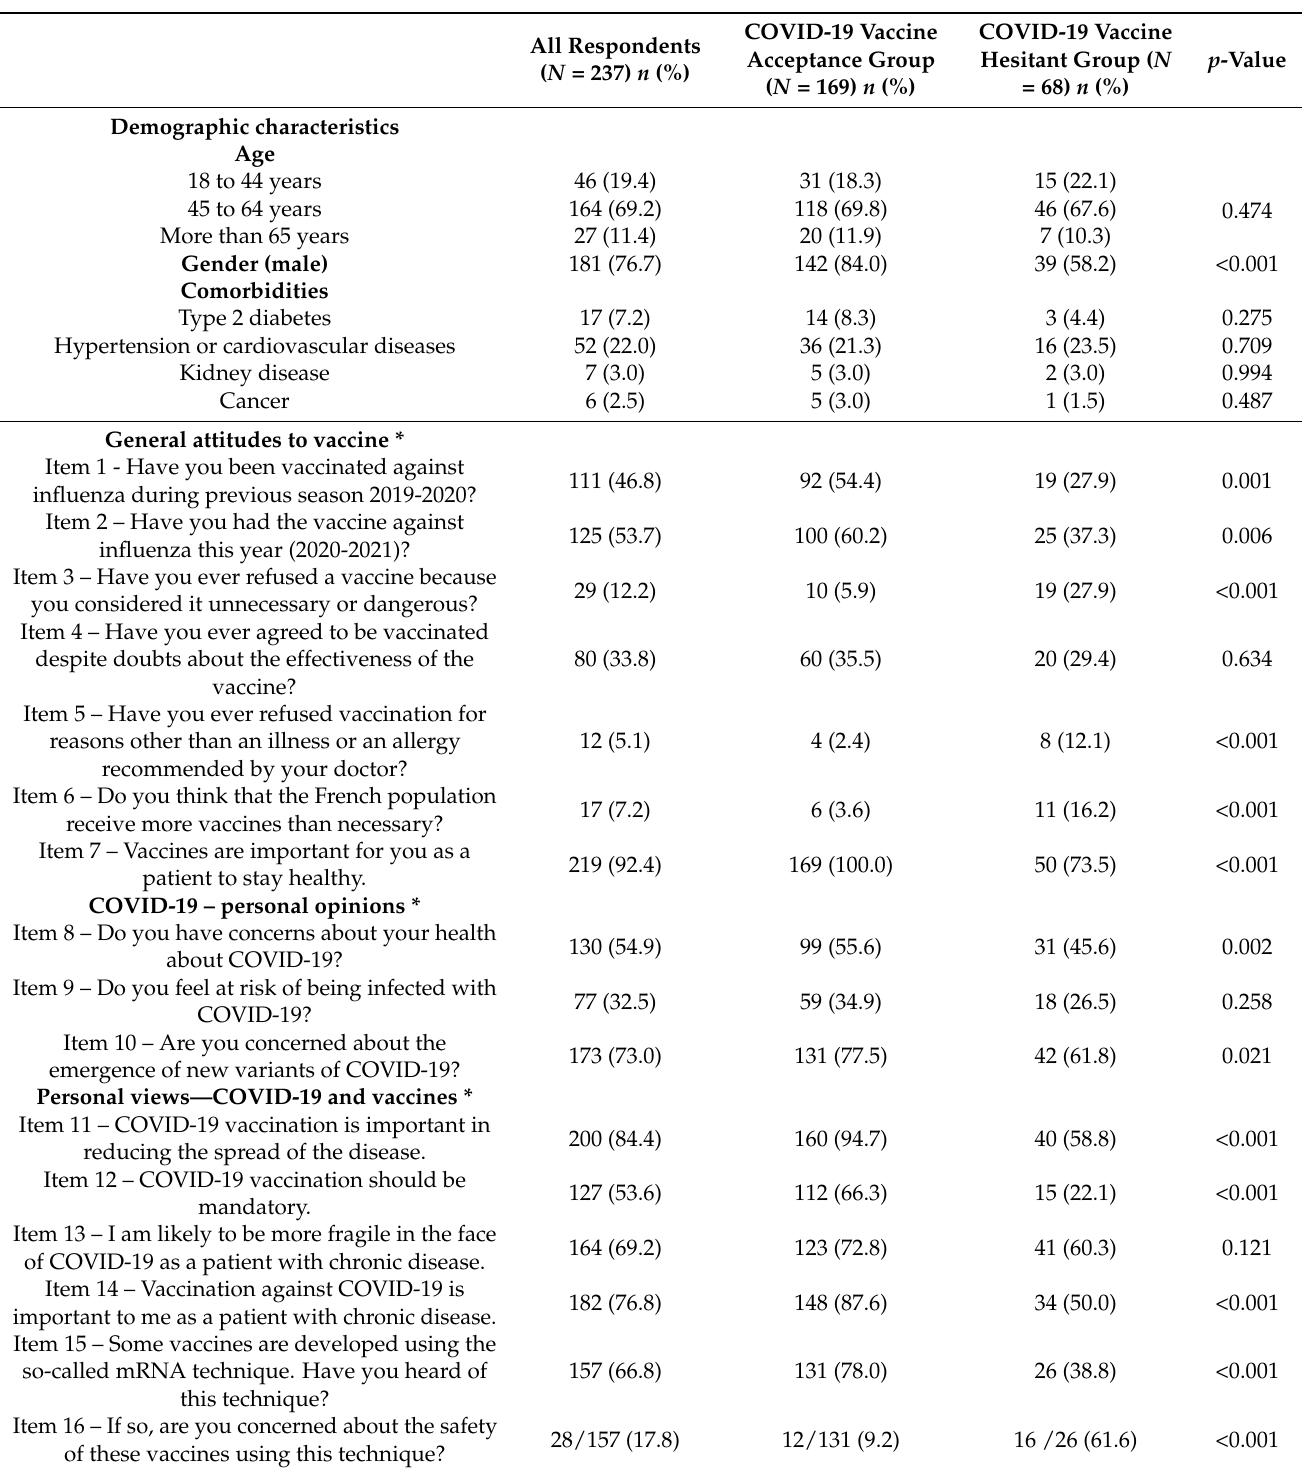
Table 1. Survey responses among the COVID-19 vaccine acceptance and hesitant